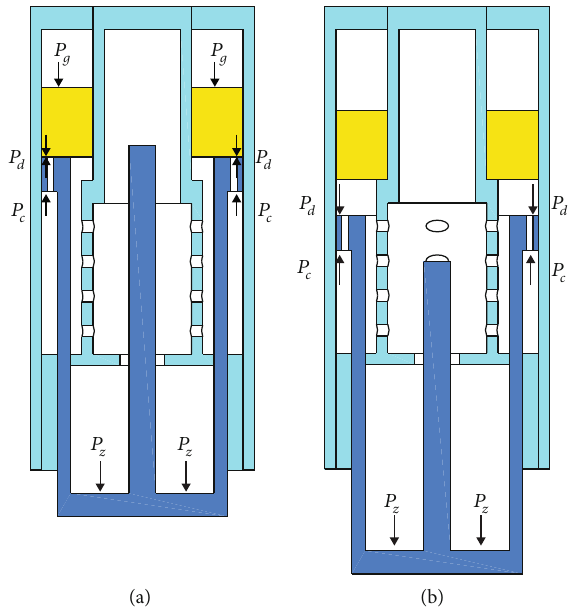
Figure 3: Force analysis of piston